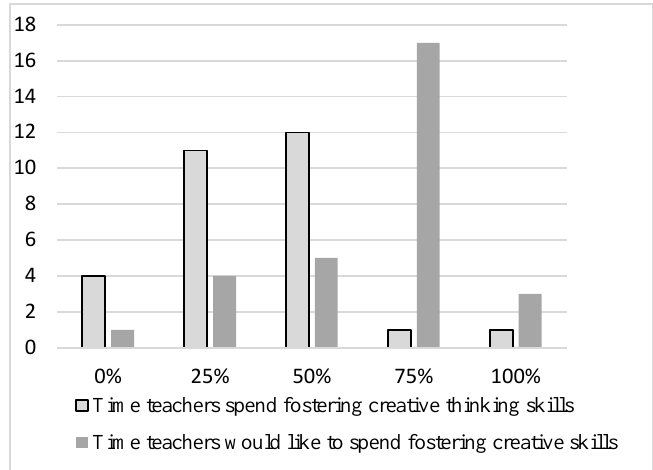
Fig. 4. Time of lessons spent on fostering creative thinking skills